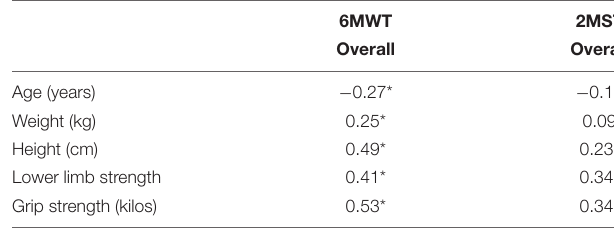
TABLE 3 | Correlation between both tests and biodemographic variables.